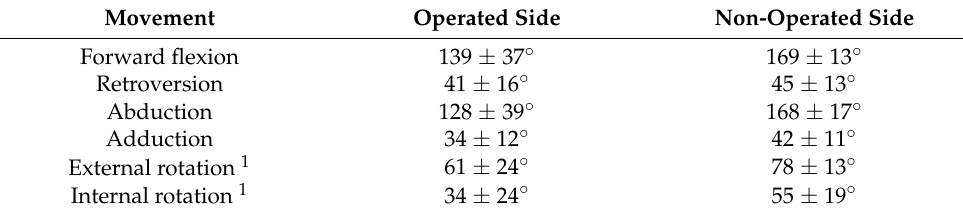
Table 2. Range of motion.